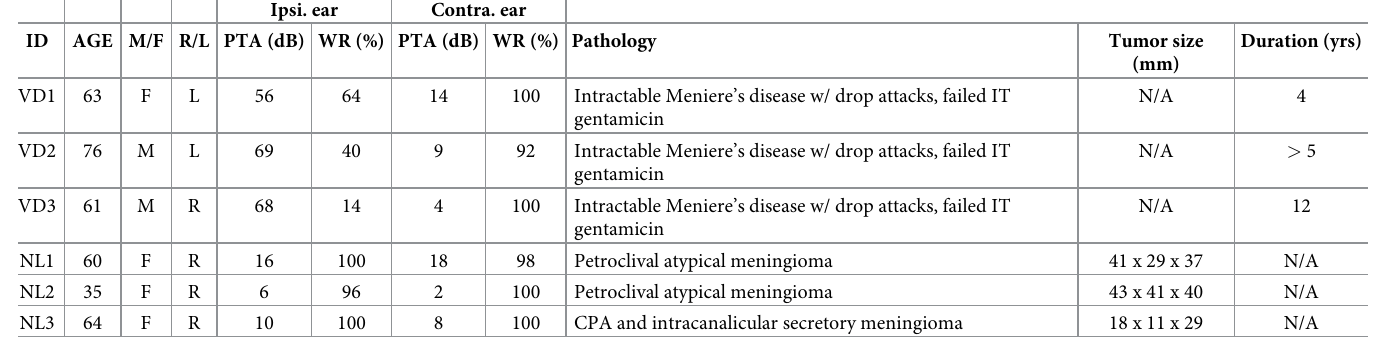
Table 2. Patient demographics. VD1-3, vestibular dysfunction samples 1–3; NL1-3, normal samples 1–3; M/F, male/female; PTA, pure tone average in decibels (dB); WR, word recognition; IT, intratympanic; Ipsi, ipsilateral; Contra, contralateral. Ipsi. ear Contra. ear